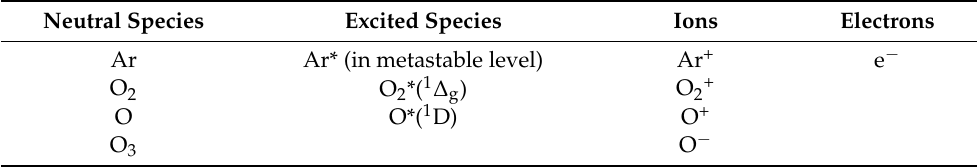
Table 1. Various species incorporated in the plasma model. Neutral Species Excited Species